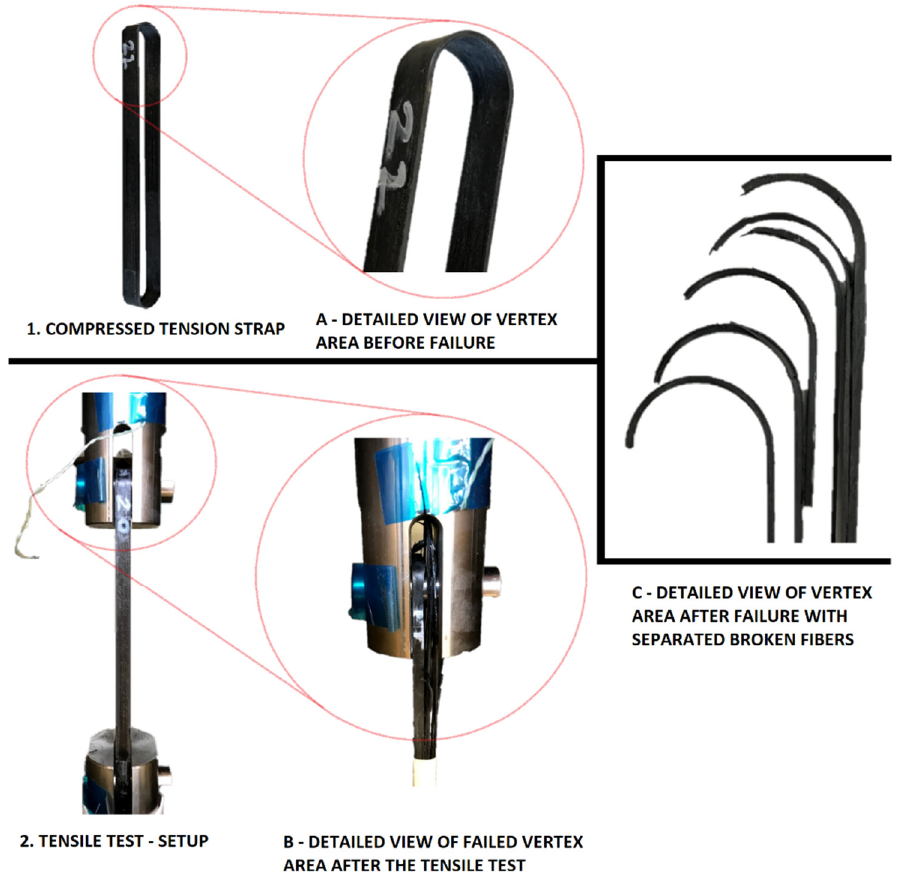
Figure 8. Tensile test setup with compressed strap and a magnified view of the vertex area before and after the failure. Table 4. Results of the tensile tests of the stretched and compressed 3D-printed CFRP straps under quasi-static conditions. The six strap specimens are depicted in Appendix